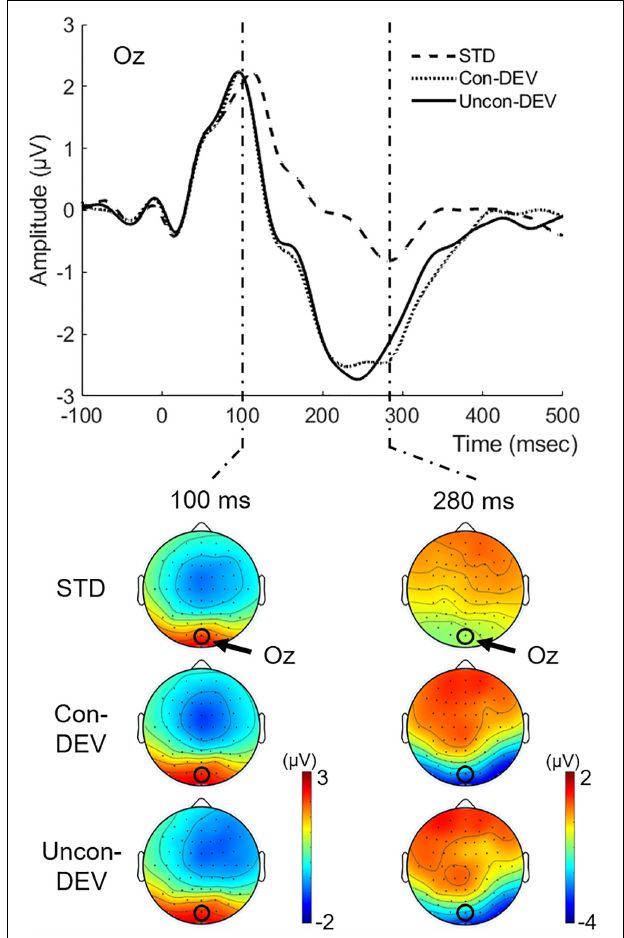
FIGURE 3 | Grand-averaged VEPs to the target image for each condition. VEPs at Oz and their isocontour maps at latencies of 100 and 280 ms were illustrated for each condition. VEPs in both the Con-DEV condition and the Uncon-DEV condition were more negatively enhanced than VEP in the STD condition at a latency range of approximately 100–400